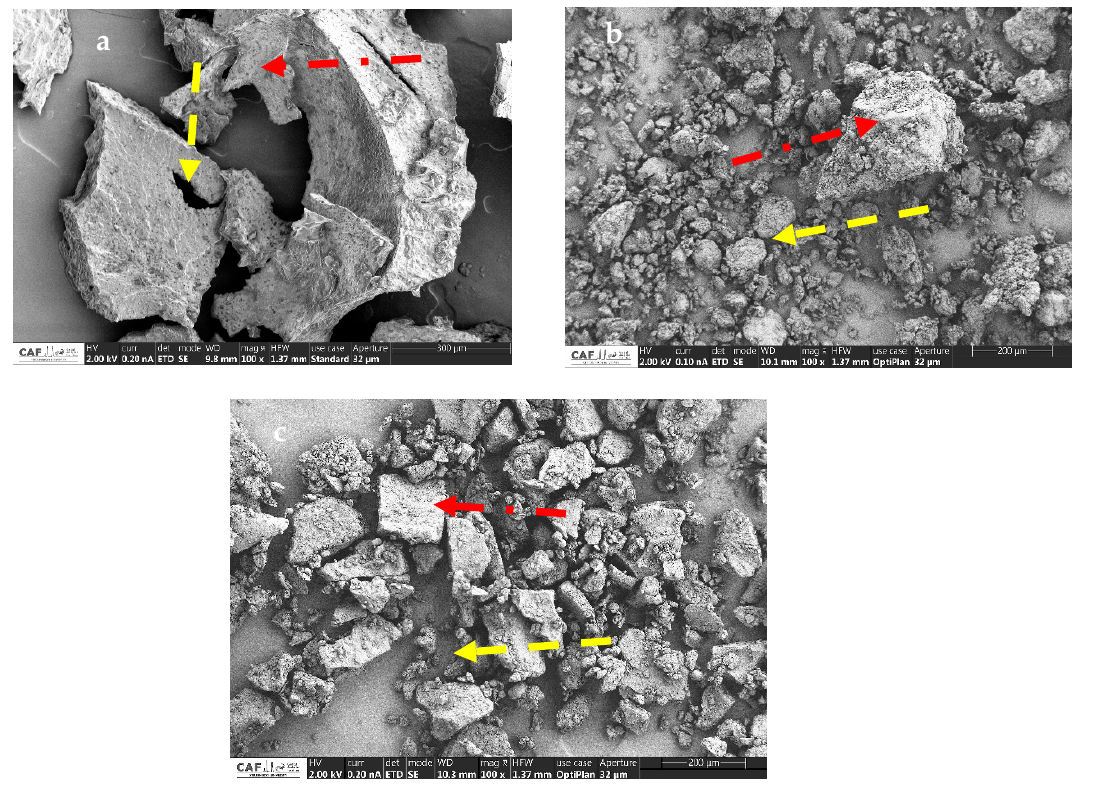
Figure 2. Scanning electron micrographs of Bambara groundnut protein isolate (BGNPI) ( a ), Moringa oleifera leaf protein isolate (MOLPI) ( b ), and their complex (BAMOLP) ( c ), (magnification ×300 for BGNPI, and ×200 for MOLPI and BAMOLP). Table 1. Colour characteristic of BGNPI, MOLPI, and BAMOLP 1,2 .